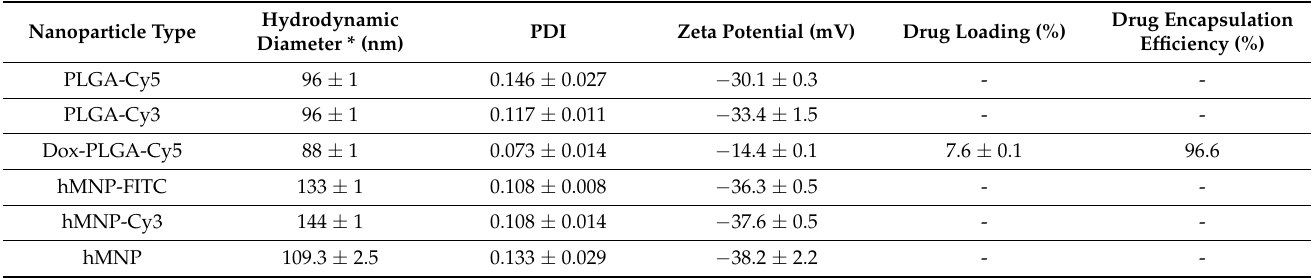
Table 1. Physicochemical parameters of fluorescently labeled PLGA NP and hMNP.